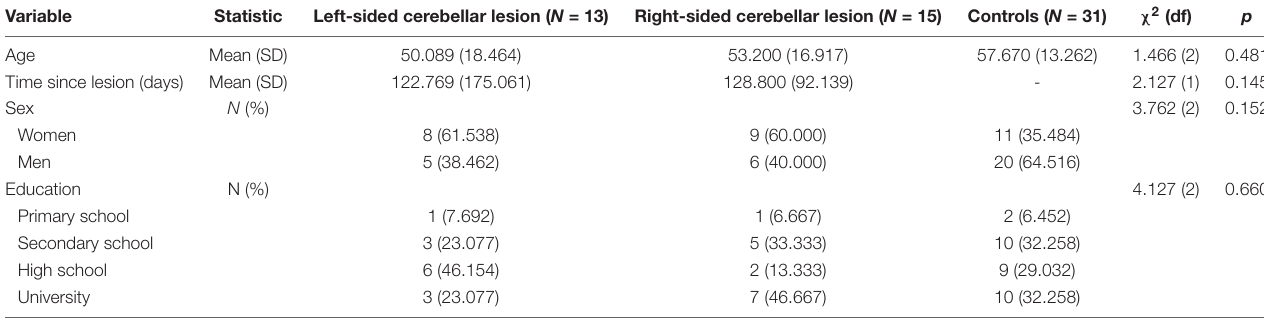
TABLE 1 | Sociodemographic characteristics of the sample.